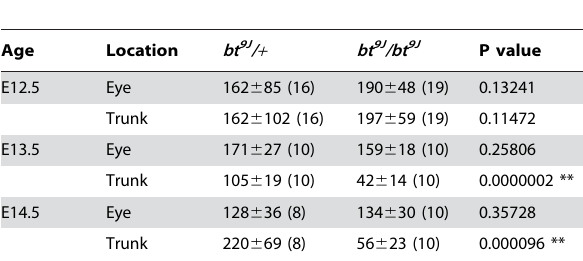
Table 1. Quantitation of melanoblasts in whole mount embryos.